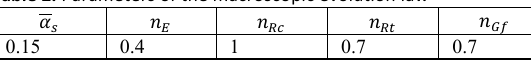
Table 2. Parameters of the macroscopic evolution law